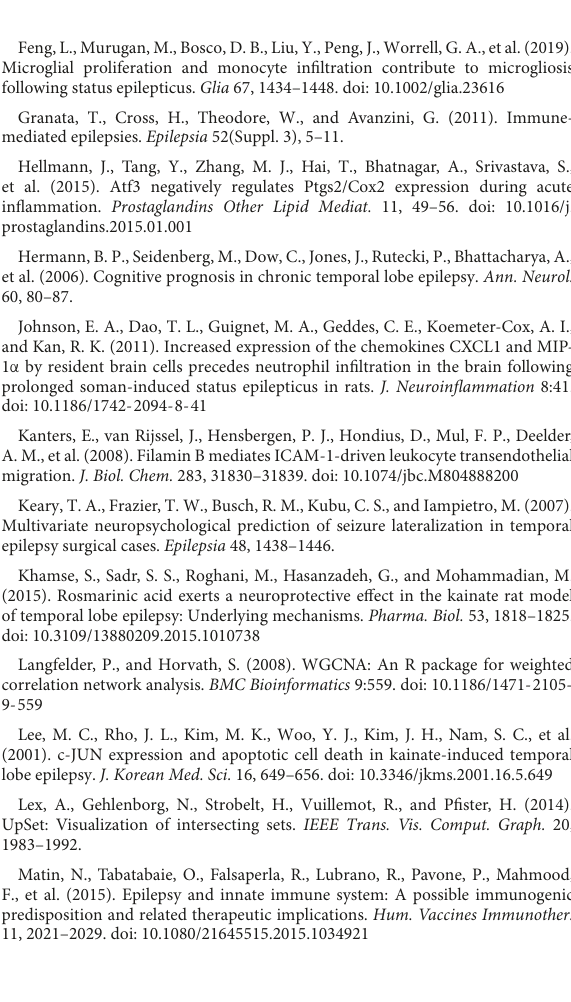
SUPPLEMENTARYFIGURE1 Construction of WGCNA modules. (A) Dendrogram of all genes clustered based on a dissimilarity measure. (B) Heatmap of the eigengene adjacency. (C) Heatmap of the module-trait relationships. (D) Scatter plot for correlation analysis between gene significance and gene module membership in the blue module. (E) Scatter plot for correlation analysis between gene significance and gene module membership in the turquoise